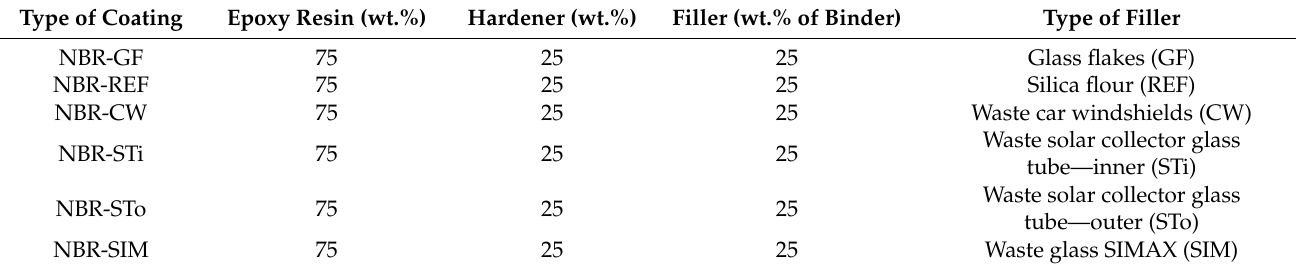
Table 3. Formulations of the epoxy coatings for testing of basic parameters. Type of Coating Epoxy Resin (wt.%) Hardener